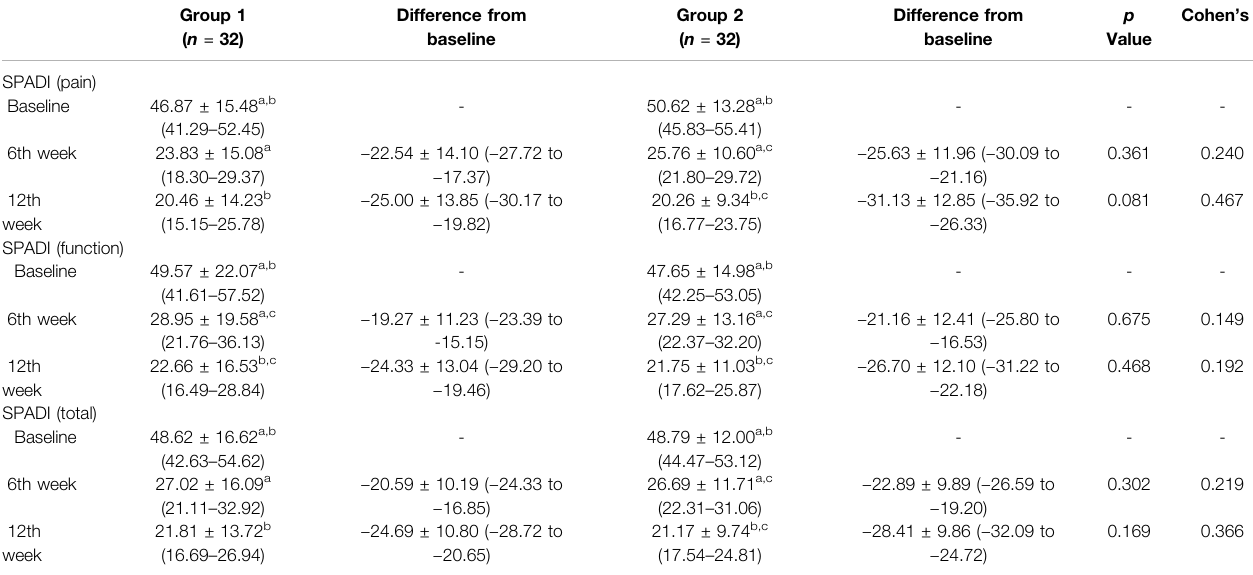
TABLE 2 | Shoulder Pain and Disability Index (SPADI) scores at the baseline, 6th week and 12th week after the injection. Group 1 ( n =